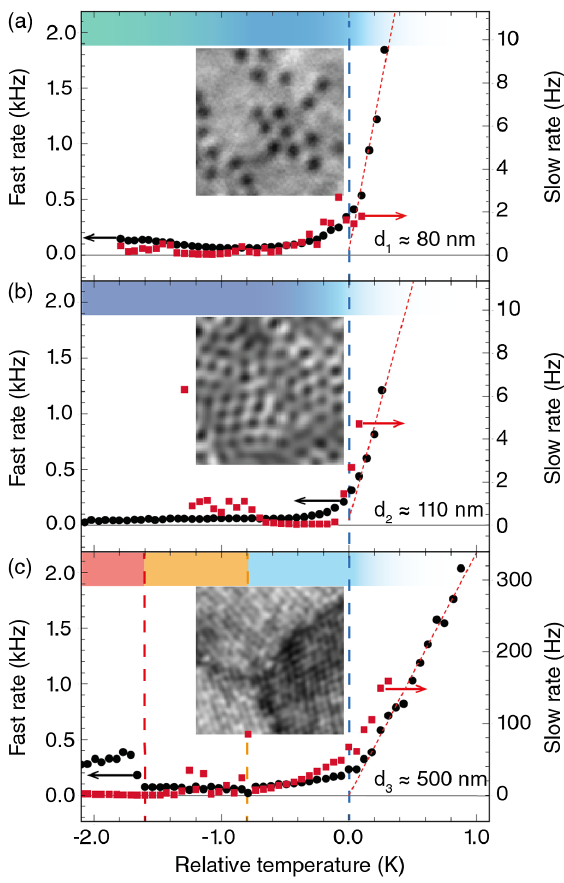
FIG. 6. Skyrmion dynamics in thin BPIII layers. (a) Temper- ature dependence of the relaxation rates of the fast and slow relaxation modes in approximately 80-nm-thin layers of BPIII, measured along line aD 1 in Fig. 5(e). (b) Temperature depend- ence of relaxation rates in approximately 110-nm-thin layers of BPIII, measured along line bD 2 in Fig. 5(e). (c) Temperature dependence of relaxation rates in approximately 500-nm layers of BPIII, taken along the line D 3 D 4 in Fig. 5(e). The isotropic phase continuously evolves into BPIII, followed by BPI. The zero of the relative temperatures in (a) – (c) is determined by extrapolating the softening-mode frequency near the isotropic phase to zero.